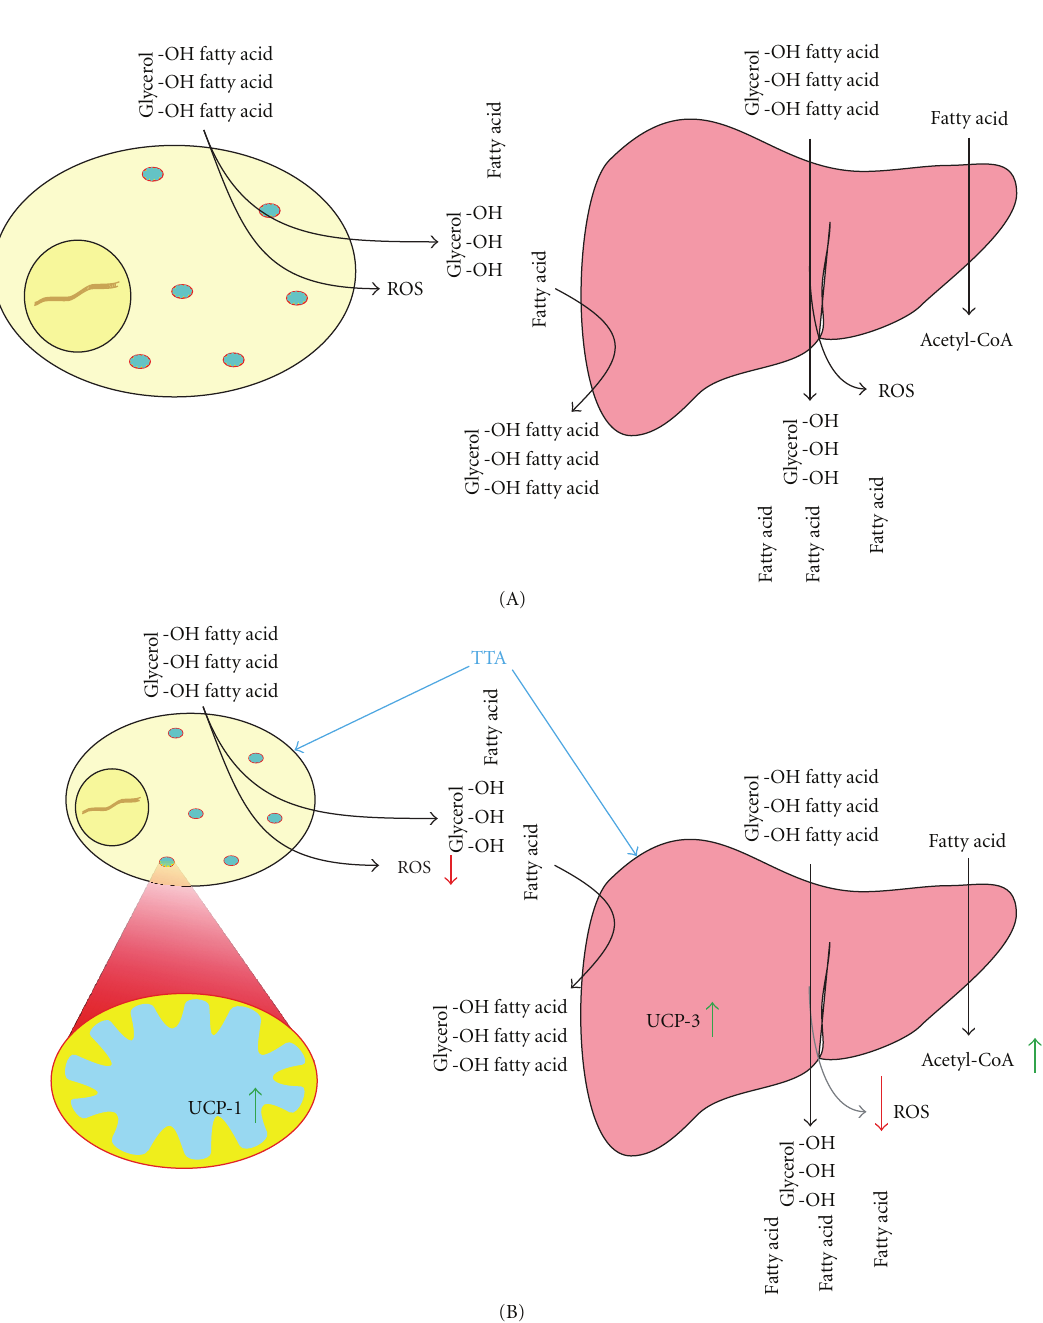
Figure 3: (A) During obesity, the adipocytes will have reduced lipid storage capacity, leading to increased lipolysis and release of free fatty acids (FFAs), inflammatory agents, and disturbed adipokine release. The FFAs will be repackaged to triglycerides (TGs) in the liver where they are released as very low-density lipoprotein particles (VLDL). Together this has secondary e ff ects on organs such as skeletal muscle and pancreas, as well as liver, and can result in hyperlipidemia, tissue lipid deposition, mitochondrial malfunction, insulin resistance, increased insulin production, and pancreatic β -cell disruption. (B) The e ff ect of tetradecylthioacetic acid-(TTA-) treatment on metabolic syndrome. In the liver, TTA treatment will increase the degradation of FFA, by the induction of both mitochondrial and peroxisomal genes involved in β -oxidation. The excess FFA released from adipose tissue during metabolic syndrome (hyperlipidemia) is drained from the blood, thereby reducing TG, cholesterol, and FFA levels. In addition the TTA-induced increase in uncoupling protein 3 (UCP3) could increase energy expenditure, as well as function as a protection from the excess ROS production observed with obesity and high levels of FA degradation. The e ff ect of TTA on liver is probably due to PPAR α -mediated mechanisms, while the e ff ect on adipose tissue may arrive from PPAR γ as well as PPAR α activation. In adipose tissue, the main e ff ect of TTA is an increase in the brown adipose tissue marker Ucp 1 in visceral adipose tissue (VAT) indicating higher energy expenditure and heat production. The higher metabolic activity of VAT compared to SAT will cause it to be the major source of FFA during increased hepatic β -oxidation. Together, this may explain the specific reduction of these risk-linked adipose depots with